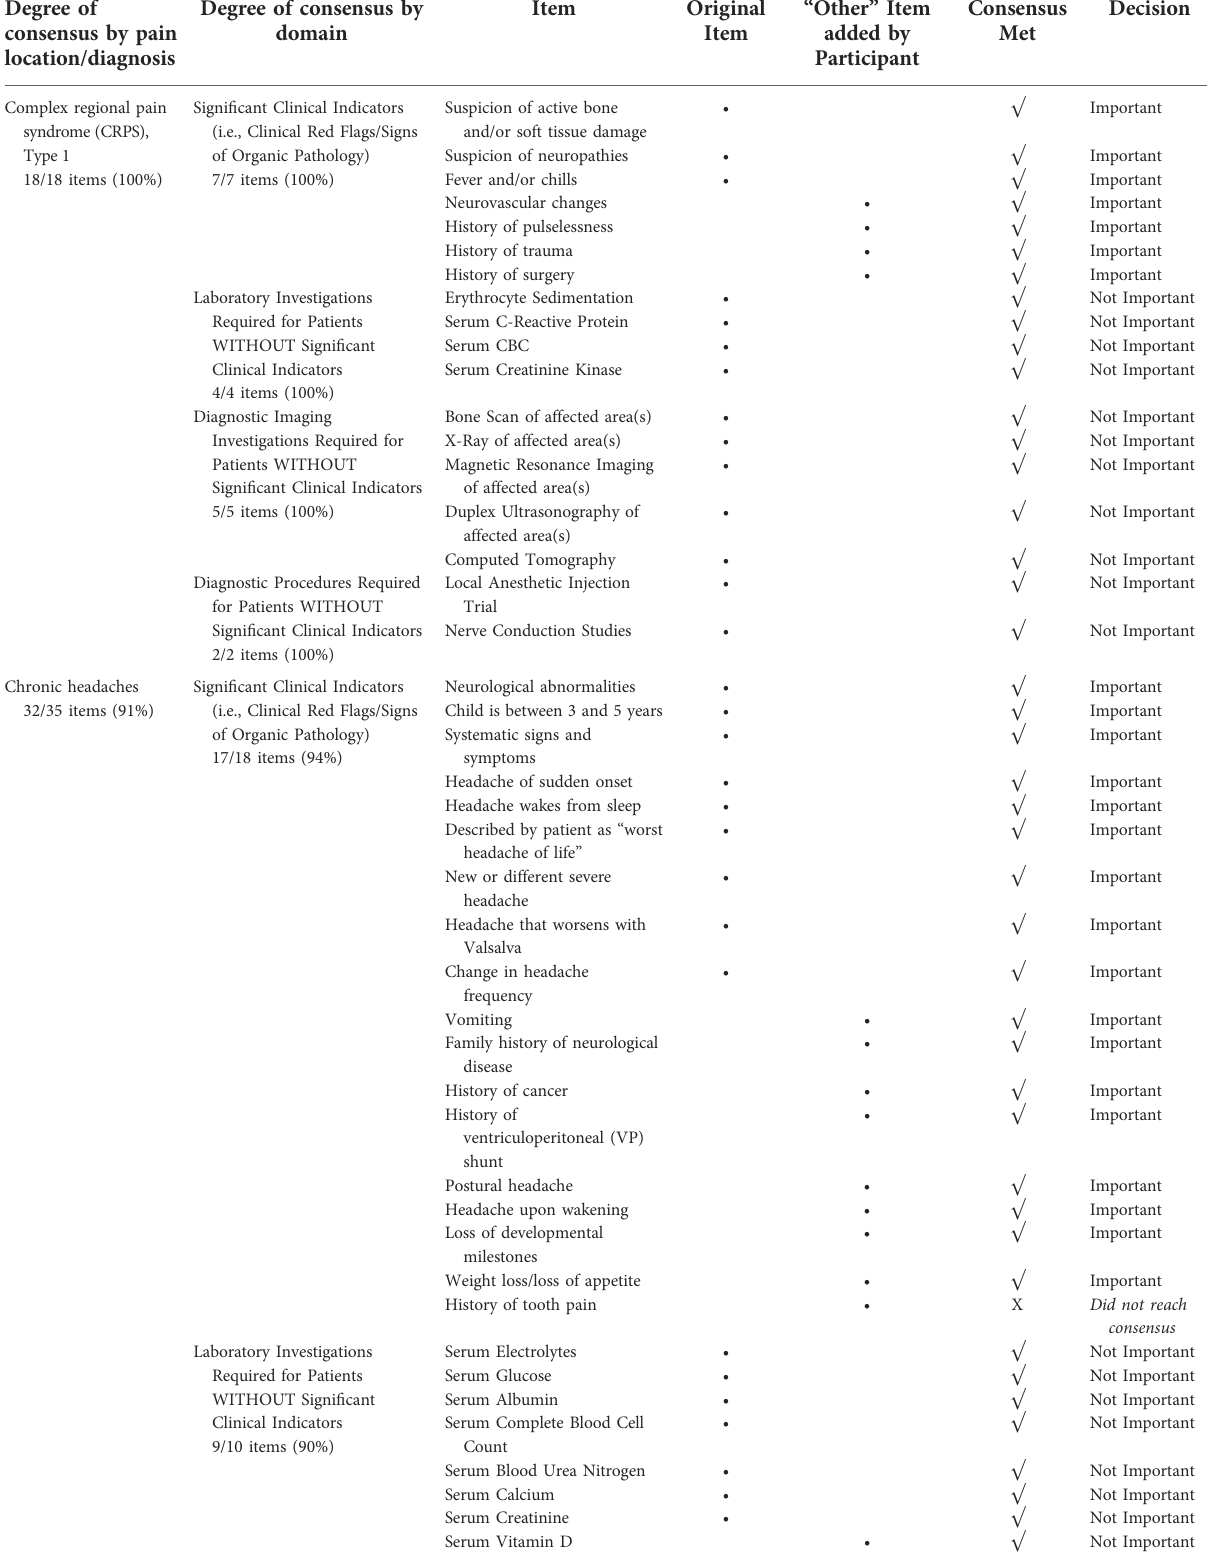
TABLE 2 Consensus. Degree of consensus by pain location/diagnosis Complex regional pain syndrome